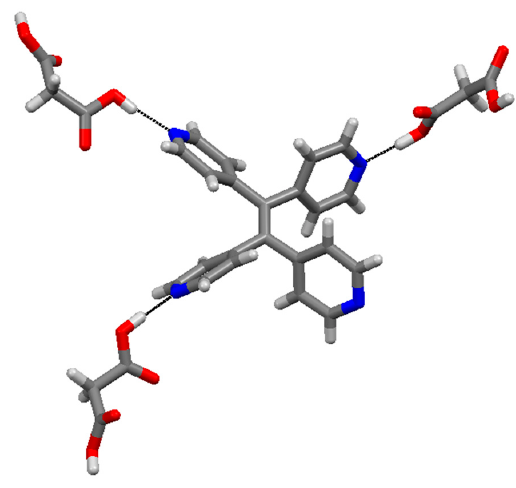
Figure 4. Hydrogen bonding interactions in 7 (malonic acid) 1.5 co-crystals.